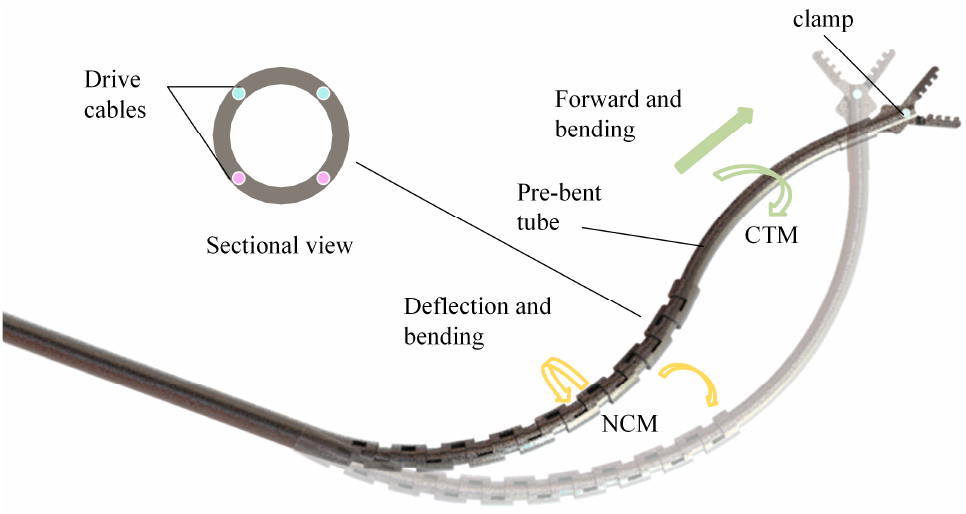
Figure 3. A bio-inspired continuum robot compound composed of a CTR with an NCR.